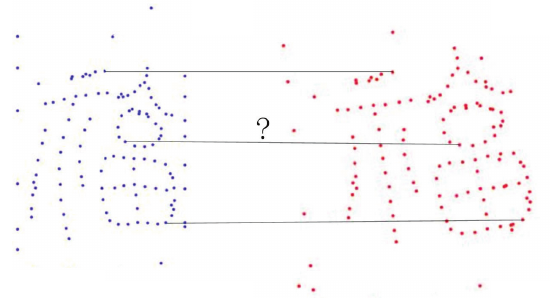
Figure 3. Pairwise point set registration problem: find the correspondences and the transformation of two point